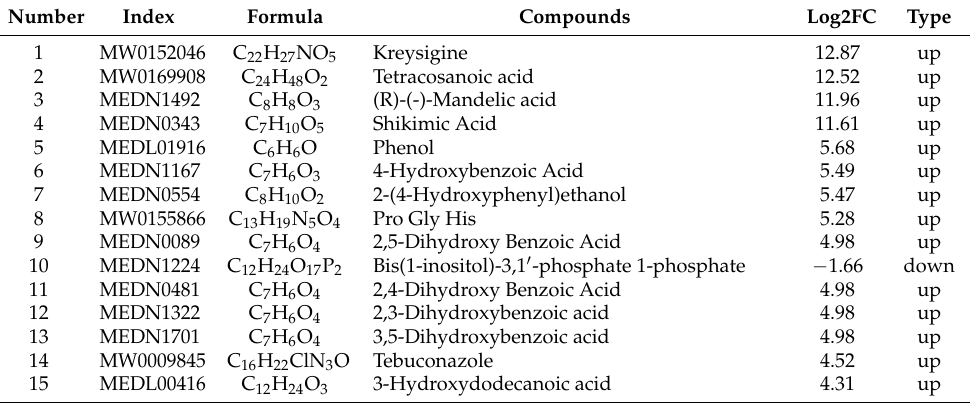
Table 2. Significantly different metabolites putatively identified by